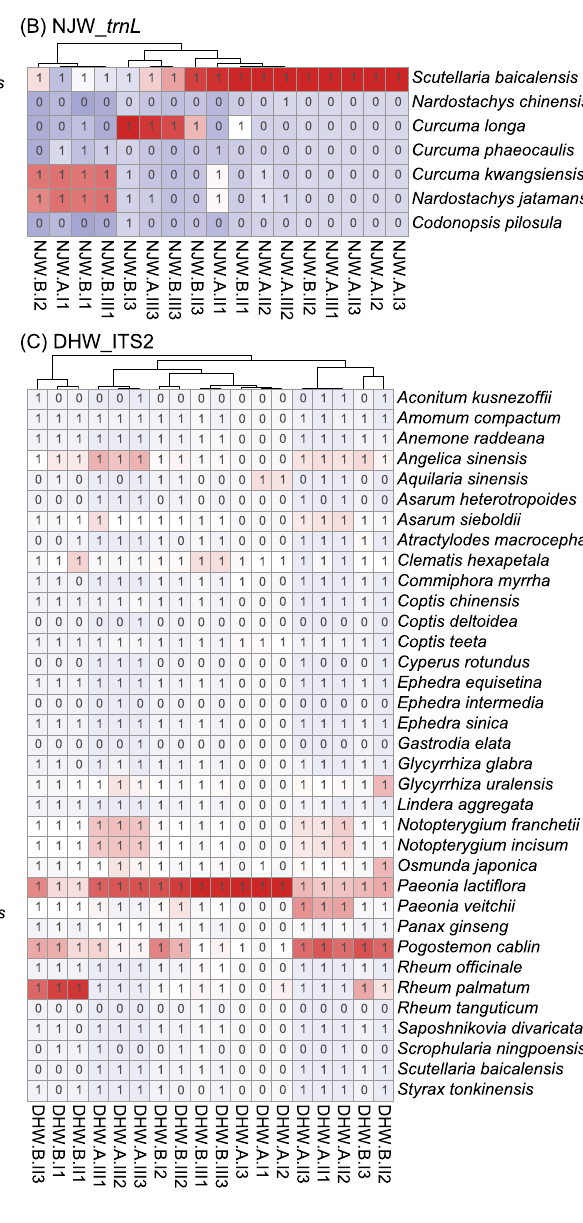
Figure 3. The distribution of prescribed herbal species (PHS) detected in each sample from NJW and DHW preparations. ( A ) The detected PHS in NJW samples based on ITS2; ( B ) The detected PHS in NJW samples based on trnL ; ( C ) The detected PHS in DHW samples based on ITS2; ( D ) The detected PHS in DHW samples based on trnL. Note that each column represents a sample, and each row represents a PHS. In the heatmap that was drawn in R (version 3.5.2) package “pheatmap” (https:// cran. rstud io. com/ web/ packa ges/ pheat map/ index. html), the color represents the relative abundance of PHS (normalized according to column) detected in this sample. The number “1” represents the PHS that was detected in this sample, while “0” represents the PHS that was not calculated the Euclidean distances for each pair of samples and then clustered the samples according to their similarity. We took DHW as a case study. The results showed that most DHW samples from manufacturers A and B were clustered together based on both ITS2 (Fig. 5A,B) and trnL (Fig. 5C,D) biomarkers, suggesting a high similarity of intra-manufacturer samples. The samples bought from DHW.A.II and DHW.A.III were clustered with DHW.B samples, whereas three samples bought from DHW.A.I, were gathered together, but they were distant from the other samples (Fig. 5A,B). Such separation might be caused by the existence of SHS such as Senna , Amaranthus , Glycine, and CHS such as Arachis , Brassica , Solanum, and Oryza . As for NJW (Supplemen- tary Fig. S4), the samples from two manufacturers (A&B) were scattered, based on either ITS2 or trnL , while the samples from each manufacturer were clustered together according to the batches (I, II, III), which depicted the high consistency between batches of NJW samples. The cluster analysis results of BYW and YGW samples